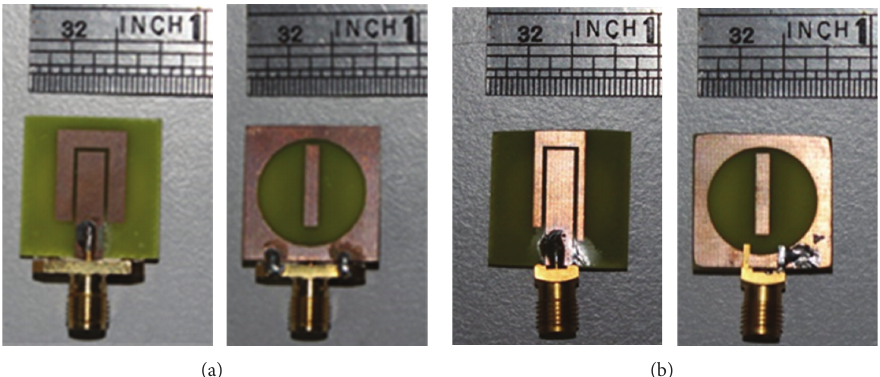
Figure 11: Resonator (a) before optimization and (b) after optimization.